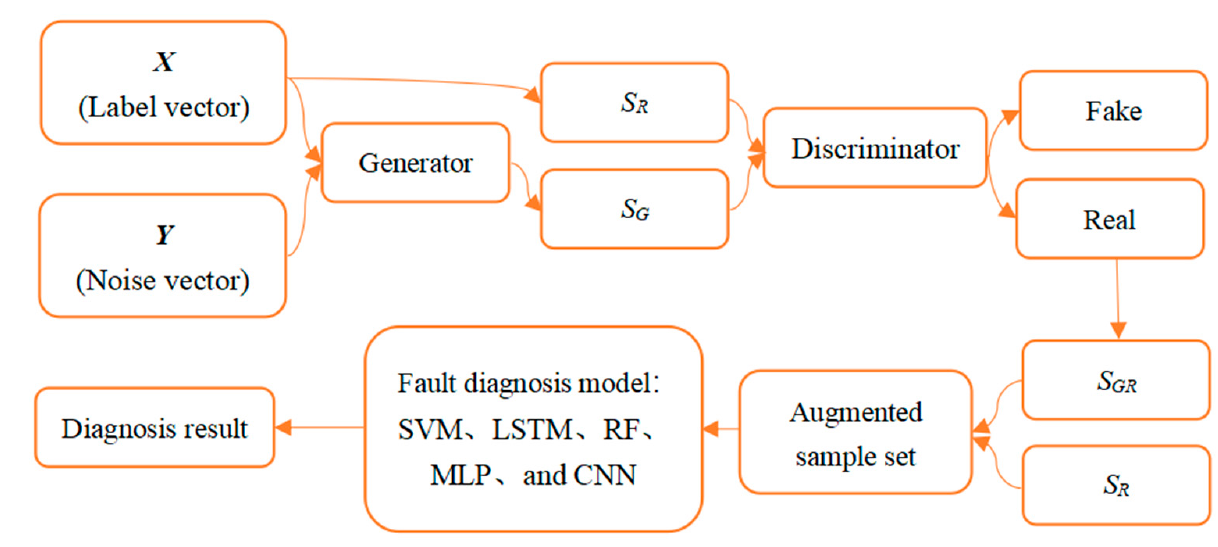
Figure 3. Architecture diagram of ACWGAN-GP algorithm.